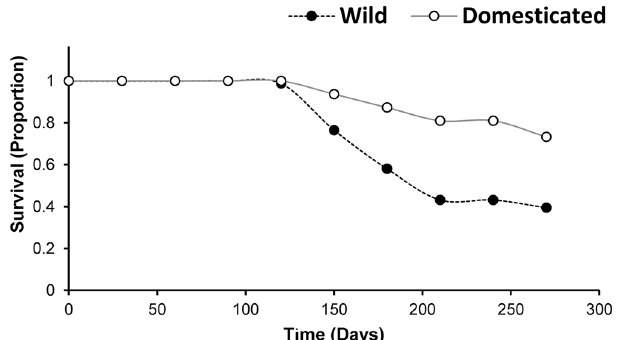
Figure 6. Survival of clones propagated using stem cuttings of wild and domesticated Cnidoscolus aconitifolius . Plants were maintained in a plant nursery in a common garden for 9 months (270